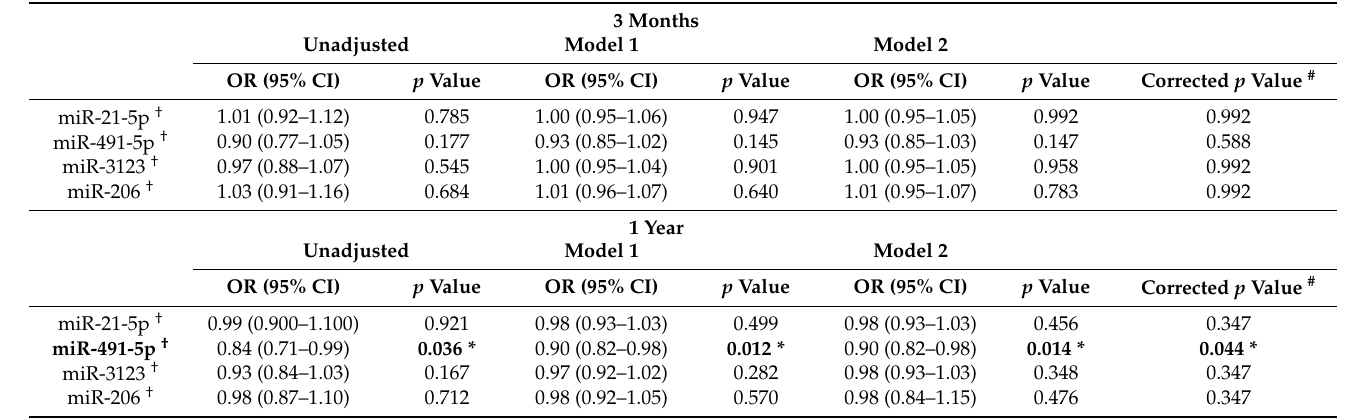
Table 2. Unadjusted and adjusted odds ratios of miRNAs expression for poor outcomes at 3 months and 1 year.